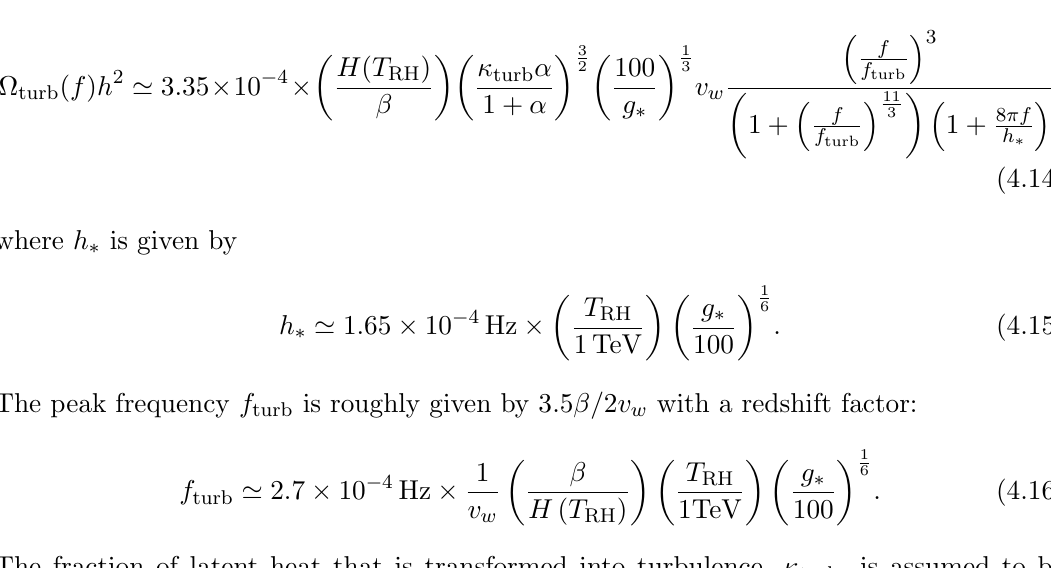
Figure 5 . The GW amplitude generated from the phase transition. Our benchmark points are (cid:22) min = 2 : 5 TeV, (cid:21) = 1 ; (cid:13) c = (cid:25) , N = 14 ; N H = 8 ( N e = 4 : 1) and N = 8 ; N H = 3 ( N e = 3 : 8), respectively. Detectable regions by eLISA [63, 85], DECIGO and BBO [86] are also shown. On the other hand, the contribution to the GW amplitude from turbulence, (cid:10) given by [76,